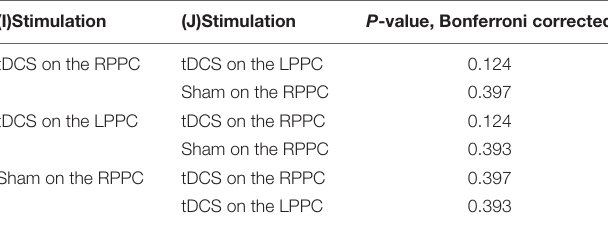
TABLE 2 | Pairwise comparisons (Bonferroni corrected) between different types of stimulation (RPPC, the right posterior parietal cortex; LPPC, the left posterior parietal